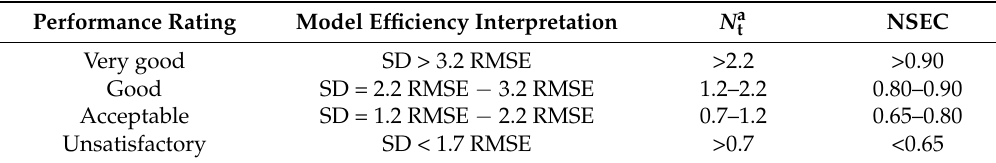
Table 1. Criteria for the goodness-of-fit evaluation [35].